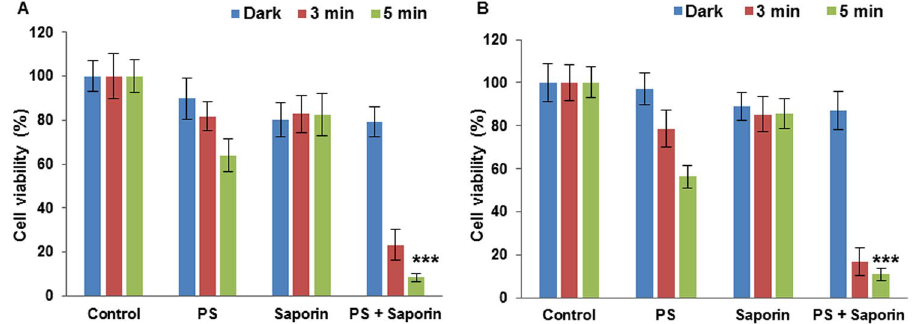
Figure 7. Light-induced cytotoxic response for 7 and 8 in KB cells, showing PDT (without saporin) and PCI (with saporin) effects. Cells were incubated with photosensitiser (550 nM) with or without saporin (20 nM)